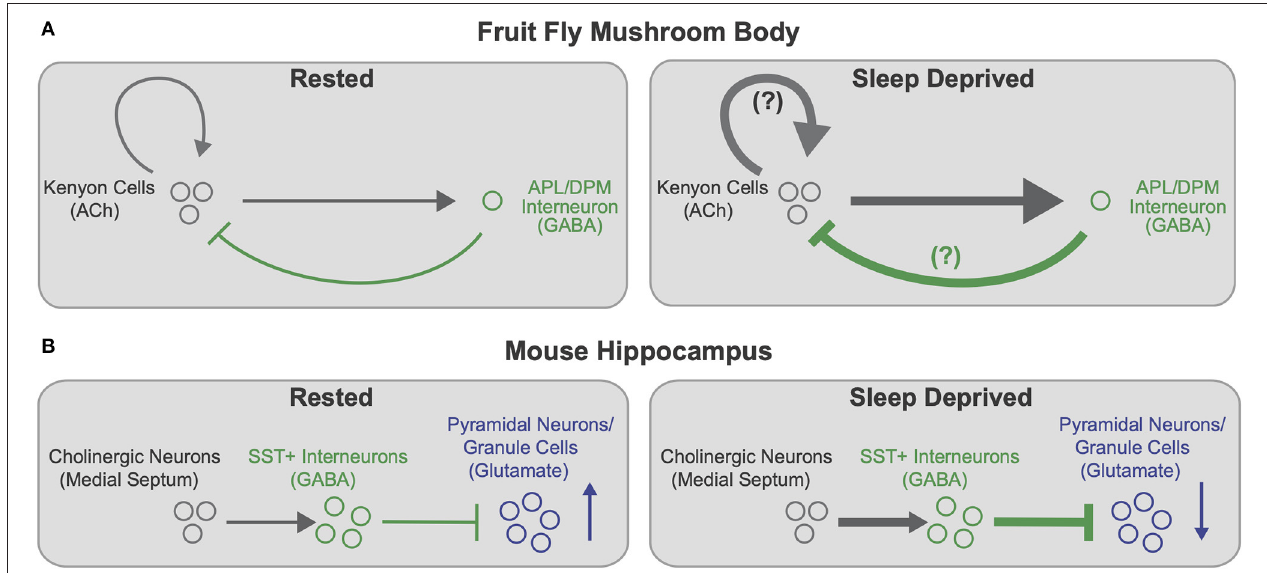
FIGURE 2 | Cell type specific effects of sleep loss on memory-encoding circuits. (A) Schematic of connectivity between memory-encoding KCs and APL/DPM interneurons in the Drosophila MB in rested (left) and sleep deprived (right) flies. Cholinergic KCs activate GABAergic interneurons, which provide feedback inhibition onto KCs. KCs also synapse back onto other KCs. After SD (right), KC > APL connectivity strengthens, presumably increasing inhibition back onto KCs. KC > KC synapses may also strengthen, further contributing to increased KC > APL connectivity. Increased inhibition from APL/DPM after SD could dampen KC > KC excitation and promote recovery sleep. Based on findings from Weiss and Donlea (2021). (B) Schematic of hippocampal circuitry including cholinergic neurons in the medial septum to the mouse hippocampus in rested (left) and sleep deprived (right) mice. Cholinergic neurons activate GABAergic SST + interneurons in the hippocampus, which inhibit memory-encoding pyramidal neurons/granule cells (principal neurons). After SD (right), enhanced cholinergic signaling increasingly activates SST + interneurons, thereby heightening inhibition and reducing activity of hippocampal pyramidal neurons and granule cells. Based on findings from Delorme et al.